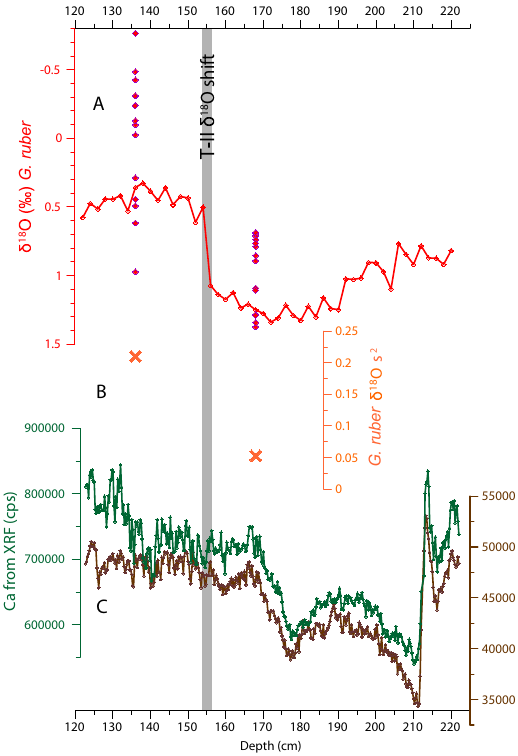
Fig. 4. Sedimentological features pointing to a limited role of bio- turbation. (A) : δ 18 O of G. ruber individuals (purple diamonds) and bulk analysis (red line, Scussolini and Peeters, 2013). (B) : corrected sample δ 18 O variance (orange, see Methods). (C) : Calcium and strontium abundance from X-ray fluorescence analysis (expressed in counts per